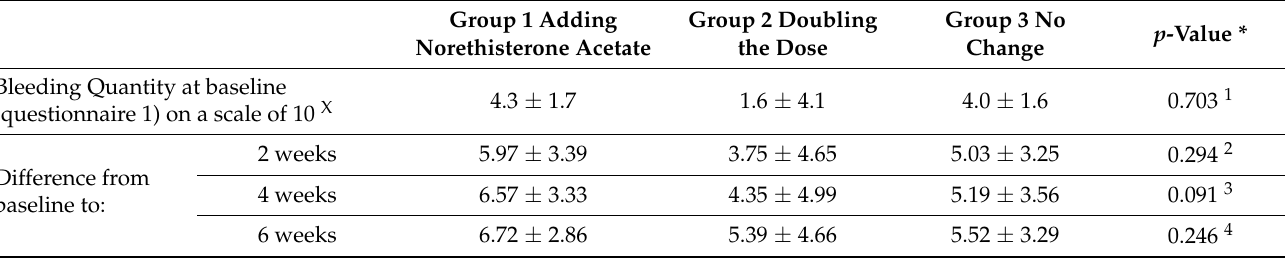
Table 3. Comparison of bleeding quantity (mean ±